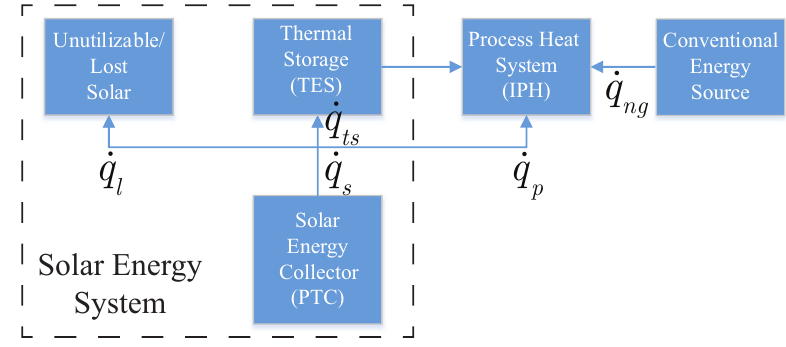
Figure 2. The block-flow diagram representation of the hybrid solar industrial process heat system being